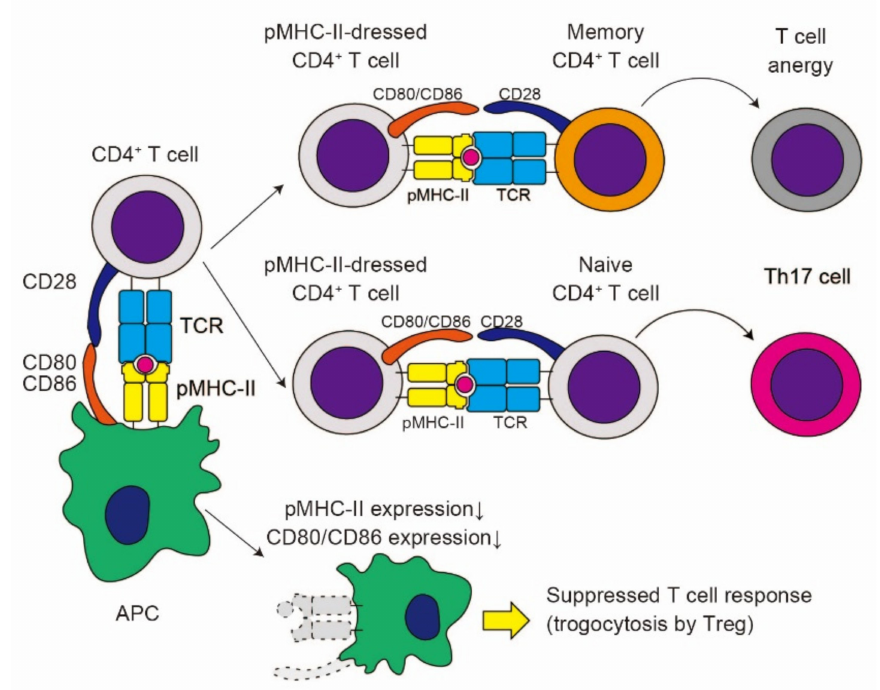
Figure 3. The impact of trogocytosis on CD4 + T cell responses. Upon formation of an immunological synapse, CD4 + T cells acquire pMHC-II complexes from APCs. pMHC-II-dressed CD4 + T cells can present antigens to memory CD4 + T cells, resulting in T cell anergy, while their antigen presentation to naïve CD4 + T cells may result in differentiation into pathogenic Th17 cells. Moreover, trogocytosis by Tregs can reduce the expression of pMHC-II and co-stimulatory molecules on APCs, leading to the suppression of the CD4 + T cell responses elicited by interaction with